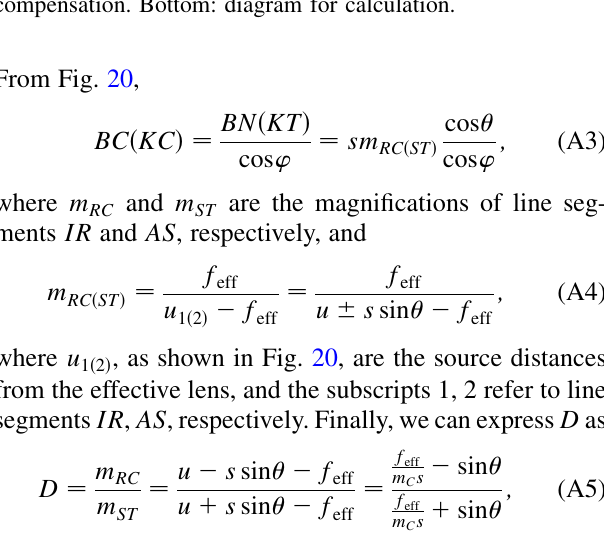
FIG. 20. Top: the effect of distortion due to Scheimpflug compensation. Bottom: diagram for